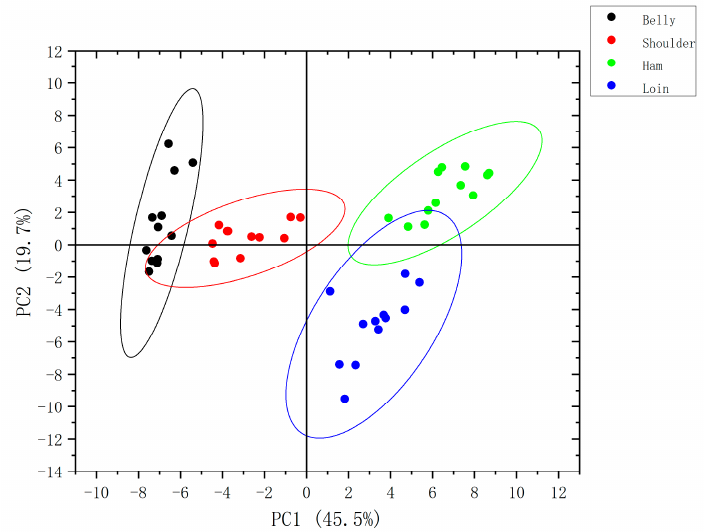
Figure 6. Plot of the principal component analysis scores of volatile organic compounds in four muscles of pork muscles of pork.